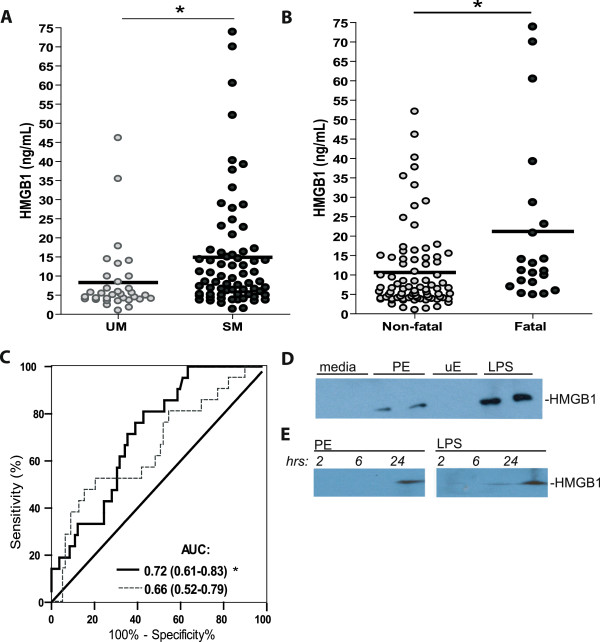
HMGB1 is released with Plasmodium falciparum infection and predictive of malarial disease severity and clinical outcome in Ugandan children. Plasma HMGB1 levels at clinical presentation are significantly higher in children with severe malaria (SM) compared to uncomplicated malaria (UM) (A) and in fatal cases when compared to non-fatal cases (B). Statistical analysis by Mann Whitney U test. * indicates a p value of <0.01. (C) Receiver operating characteristics (ROC) curves were generated for HMGB1 (solid line) and parasitaemia (dashed line) to assess the utility in predicting outcome. Area under the curve (AUC) is displayed with 95% confidence intervals in parentheses. p values were adjusted for multiple comparisons using Bonferroni-Holm’s correction (n = 2). * indicates a significant p value of <0.025 (D) HMGB1 is detectable in cultured media 24 hours following peripheral blood mononuclear cells (PBMC; 1.5 × 106 per well) (isolated from healthy, malaria-naïve donors) stimulation with parasitized erythrocytes PEs (4.5 × 106 per well) or LPS (100 ng/ml) but not after stimulation with uninfected erythrocytes (uE; 4.5 × 106 per well) or media alone. HMGB1 was analysed by western blot using rabbit polyclonal anti-HMGB1 antibodies. (E) The kinetics of HMGB1 release from PBMCs (1.5 × 106 per well) was assessed two, six and 24 hours after stimulated with PEs (4.5 × 106 per well) or LPS (100 ng/ml).